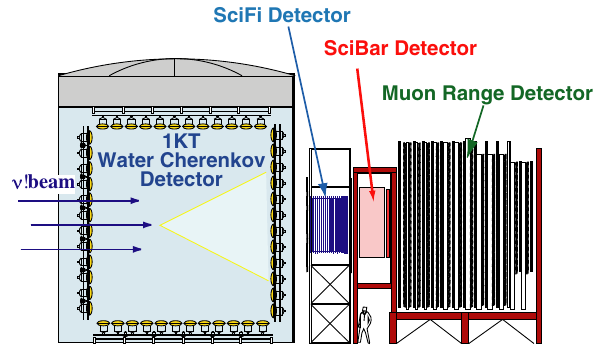
Fig. 15 The K2K-IIb near neutrino detectors. In K2K-I, the Lead– Glass calorimeter was located at the position of the SciBar detector for measurement of ν e contamination in the beam Fig. 15. By having a water Cherenkov detector at the near